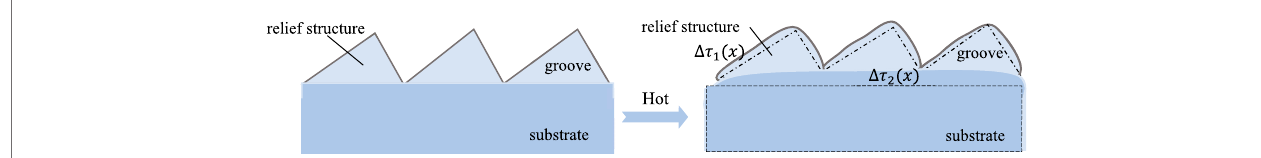
FIGURE 3 | Schematic illustration of the blazed grating before and after thermal deformation.